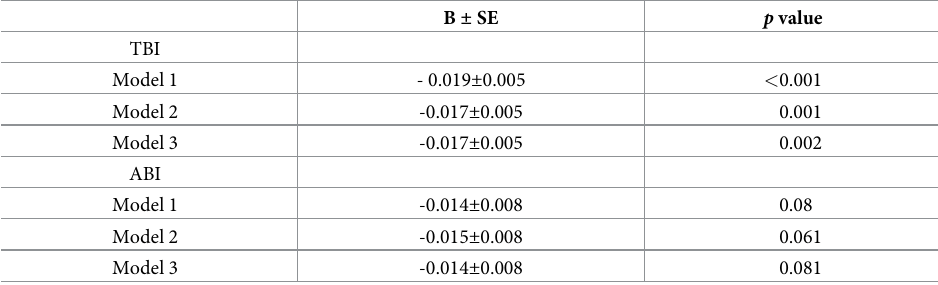
Table 2. Linear regression analysis of relation between TBI/ABI (0.1 unit) and CIMT (1mm).